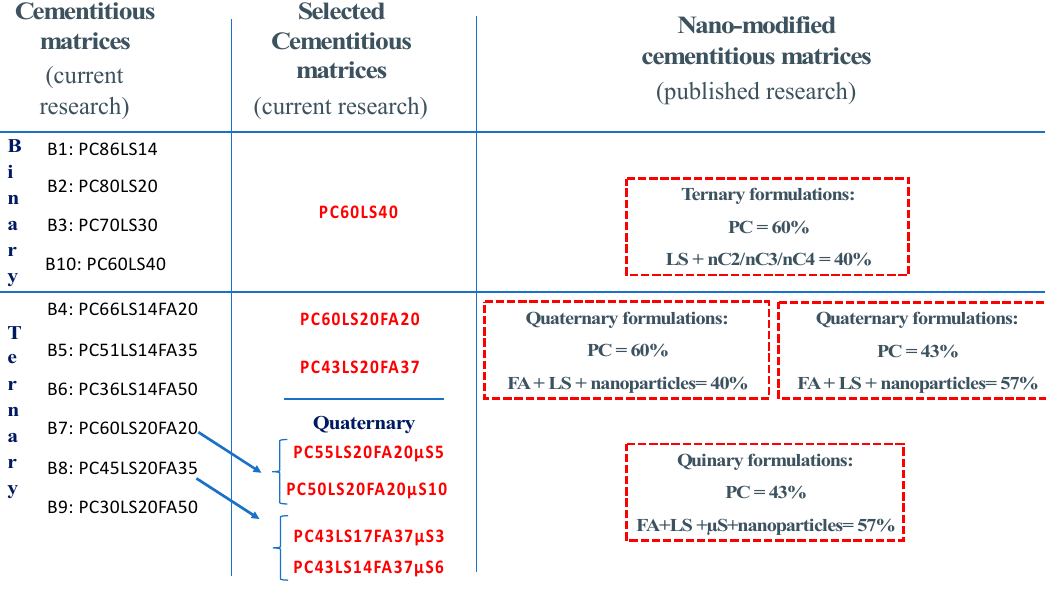
Figure 1. Development of binary, ternary and quaternary cementitious matrices in the current research and their enhancement with the incorporation of nanoparticles in published research.